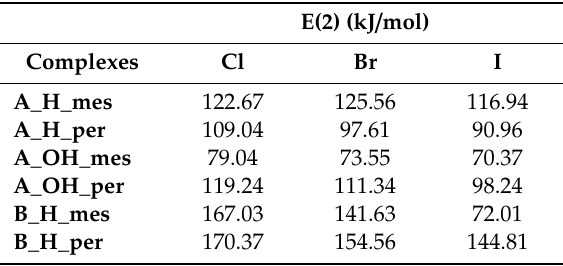
Table 4. NBO values of charge transfer energy E(2), in kJ / mol, from lone pairs of halide to σ *(X-C) antibonding